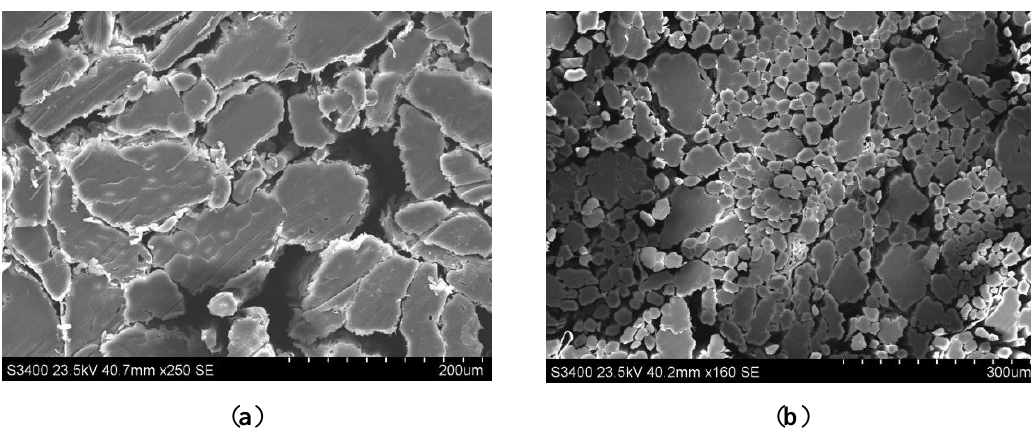
Figure 3. Cross-sectional view of ( a ) non retted and ( b ) retted flax fibre.